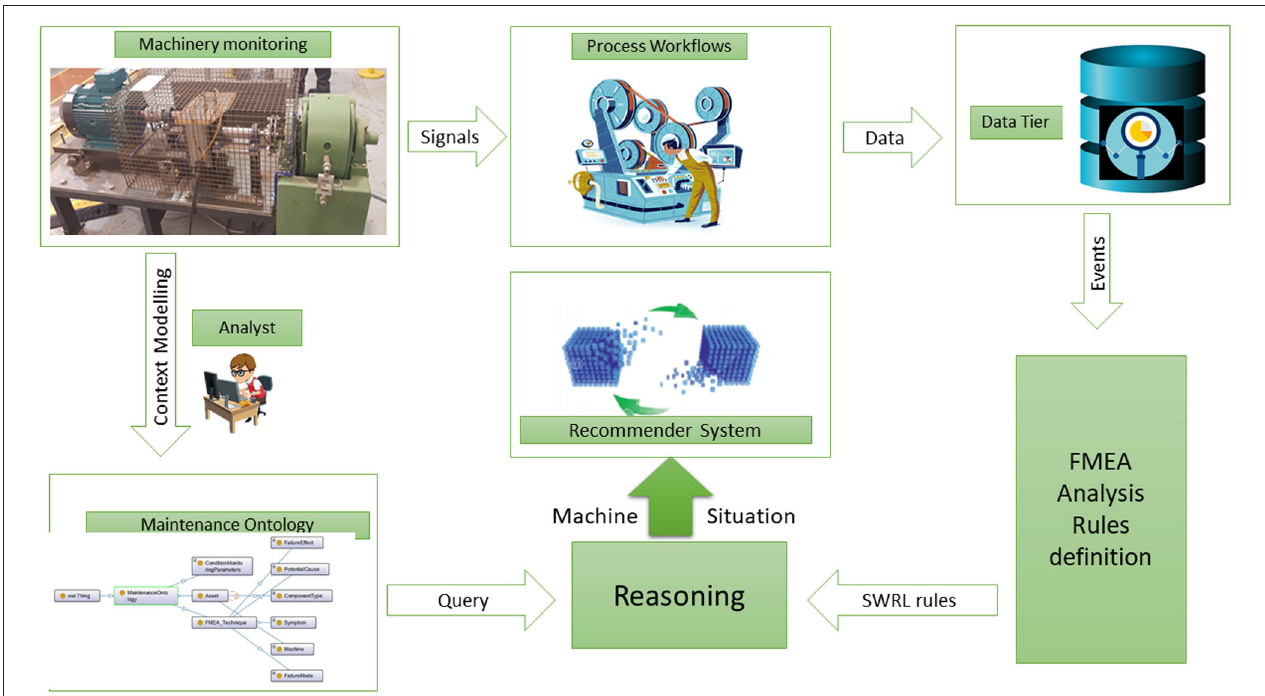
FIGURE 1 | Prototype framework.